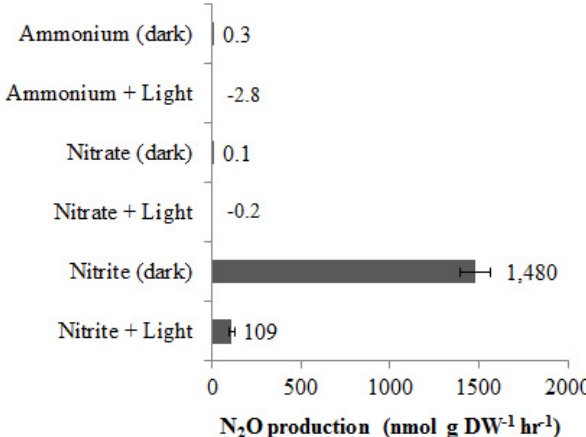
Fig. 1. Influence of nitrogen source and illumination on specific N 2 O production by C. vulgaris (0.22g DW − 1 L − 1 ). The rates shown represent averages from duplicates ± error and were deter- mined between 2.9 and 21.5h after nitrogen addition